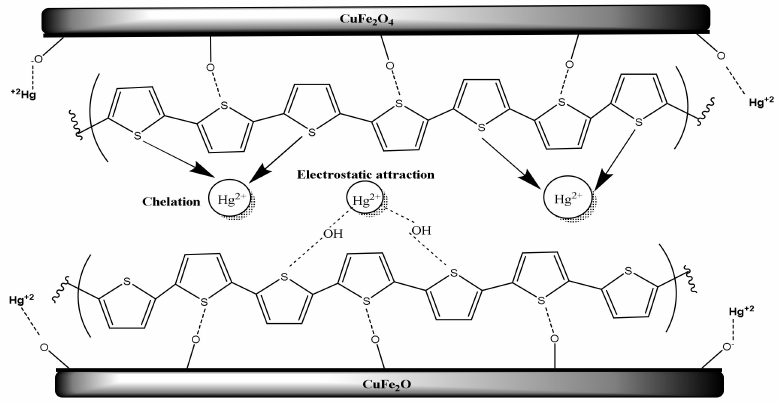
Figure 14. Schematic of Hg 2 + adsorption mechanism on CuFe 2 O 4 @Polythiophene